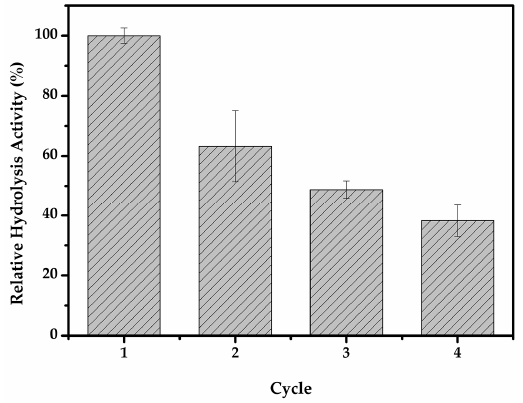
Figure 10. The relative hydrolysis activity of the pretreated biomass using immobilized cellulase.